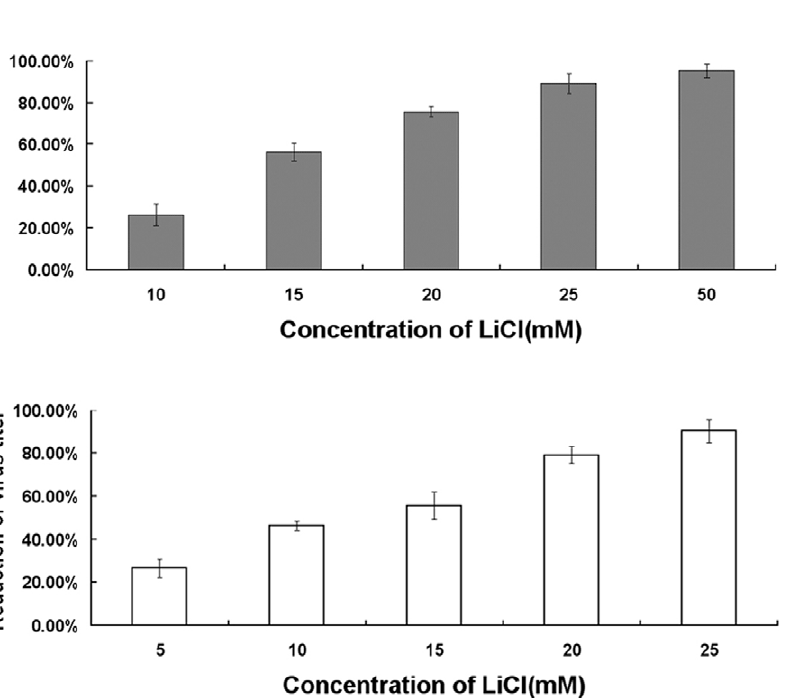
Figure 6. Antiviral activities of LiCl against other RNA viruses. The inhibitory effect of LiCl on two other RNA viruses, PEDV and BRV, in different cell lines was analyzed. The infectivity of PEDV and BRV was determined in Vero cells (A) and MA104 cells (B), respectively. The reduction of virus titer is indicated in the y axis.